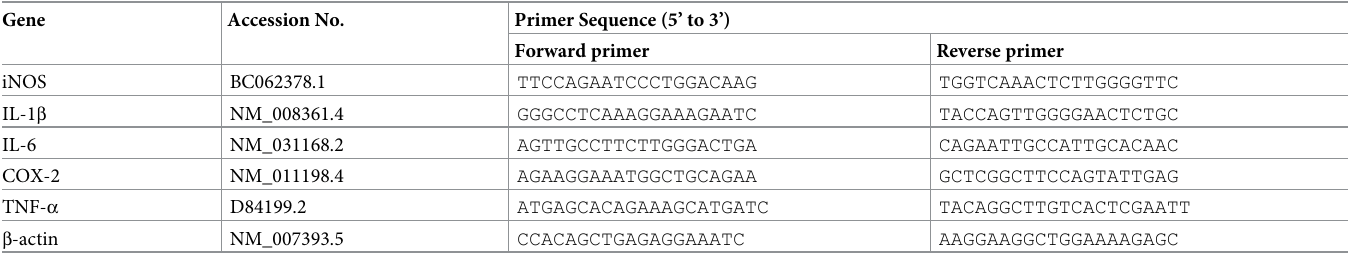
Table 1. Oligonucleotide primers used to assess anti-inflammatory effect of fermented rice cake. Gene Accession